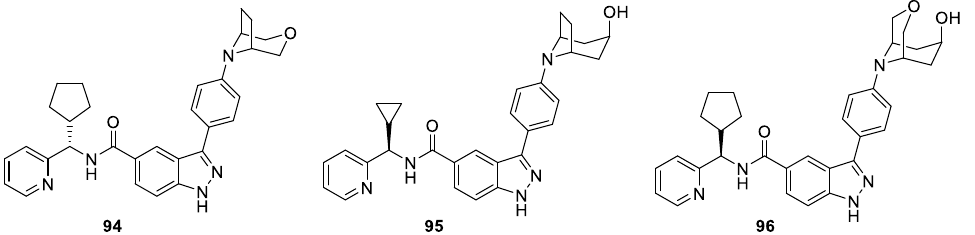
Figure 11. Chemical structures of 3-(4-(heterocyclyl)phenyl)-1 H -indazole-5-carboxamides derivatives 94 , 95 and 96 .